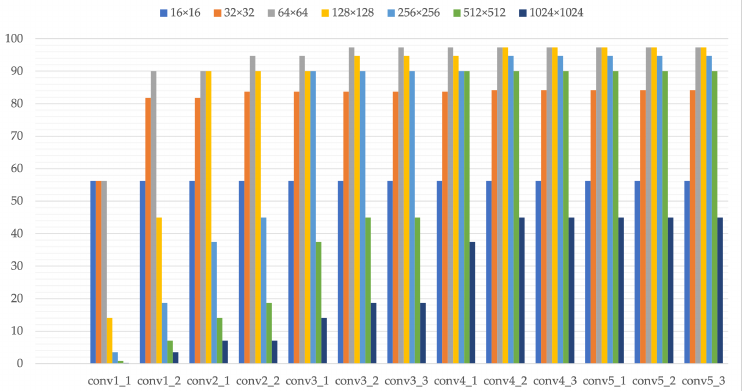
Figure 14. Utilization with respect to different array sizes and layers on